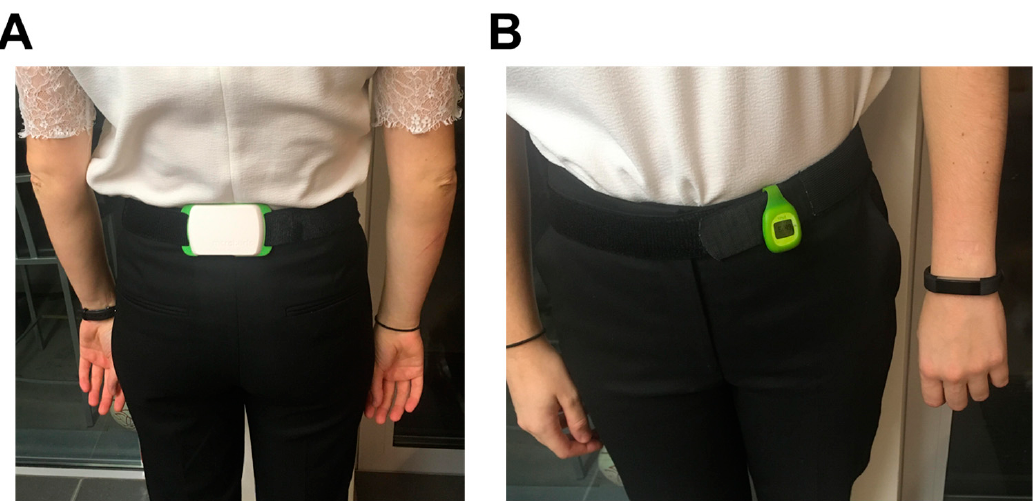
Figure 1. Placement of the DAM at the lower back (panel ( A )) and the Hip-AT and Wrist-AT (panel ( B )).